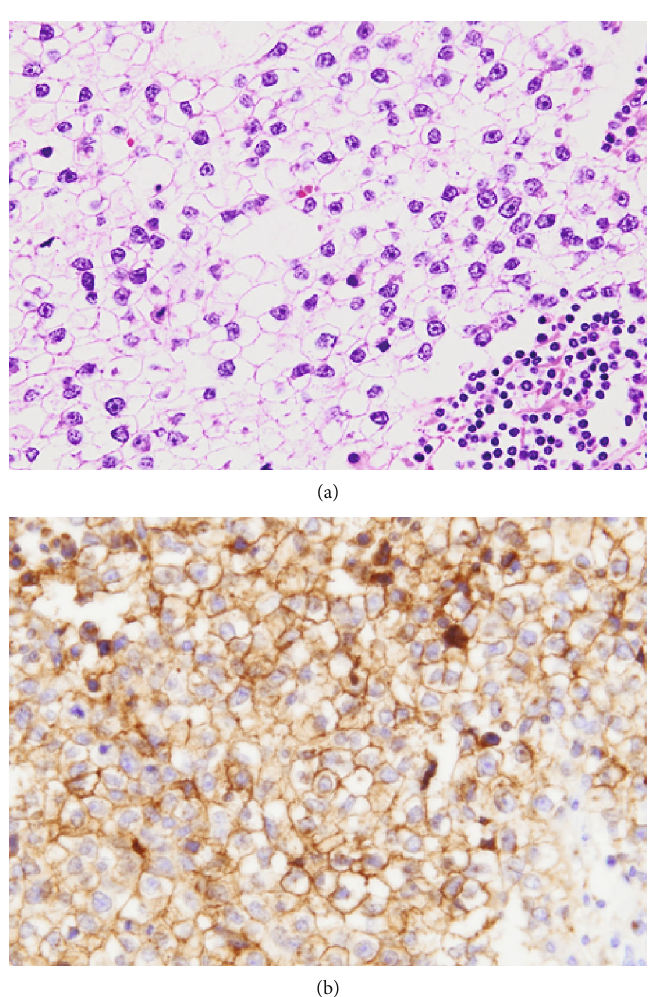
Figure 3: Microscopical fi ndings for the retroperitoneal tumor. (a) Polygonal tumor cells proliferated in sheets or nests with lymphocytes in fi ltration. (b) Immunohistochemical study for D2-40. Strong membranous D2-40 expression was